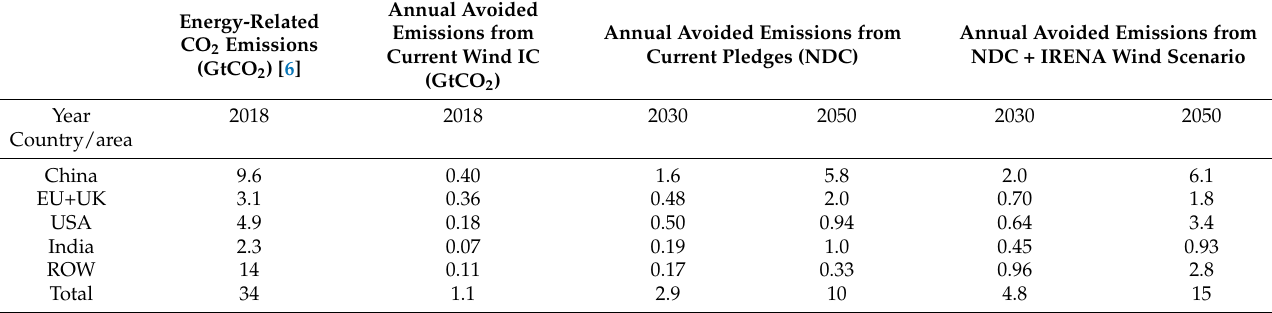
Table 3. Energy-related emissions (GtCO 2 ) in 2018, plus estimated avoided emissions in that year resulting from current use of wind energy (GtCO 2 ) plus projections of avoided emissions in 2030 and 2050 that would arise in the current pledges from each country/area were realized in full and then if those pledges were realized but the full scenario of wind expansion from IRENA is also achieved. The avoided emissions from wind energy electricity generation are estimated by assuming emissions from the current energy mix of 0.64 MtCO 2 per